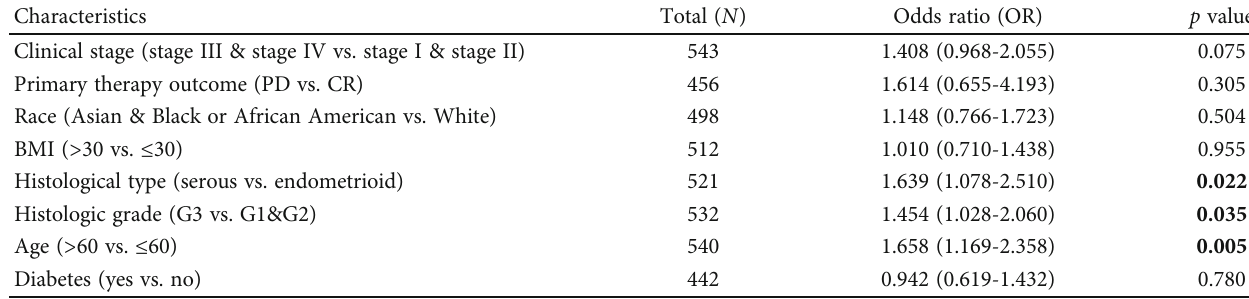
Table 1: Association between BCHE expression and clinicopathological characteristics using logistic